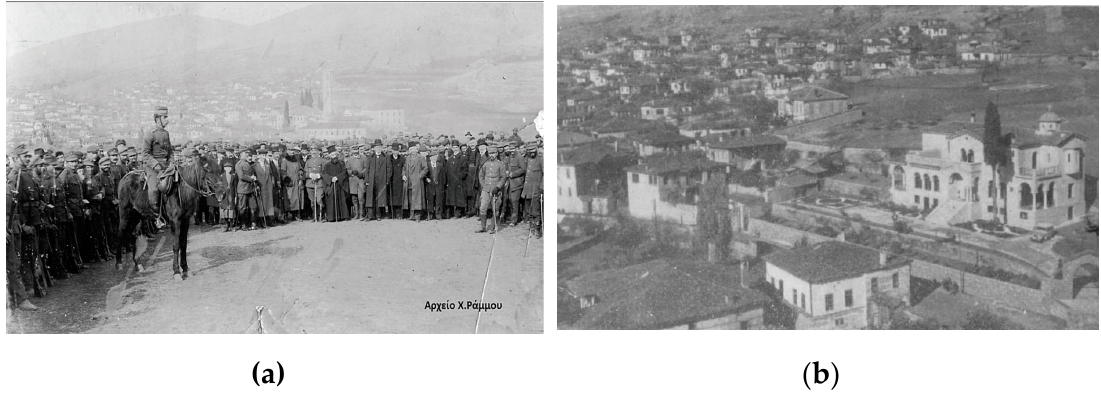
Figure 9. ( a ) Siatista in 1912. ( b ) Chora’s district in 1960.